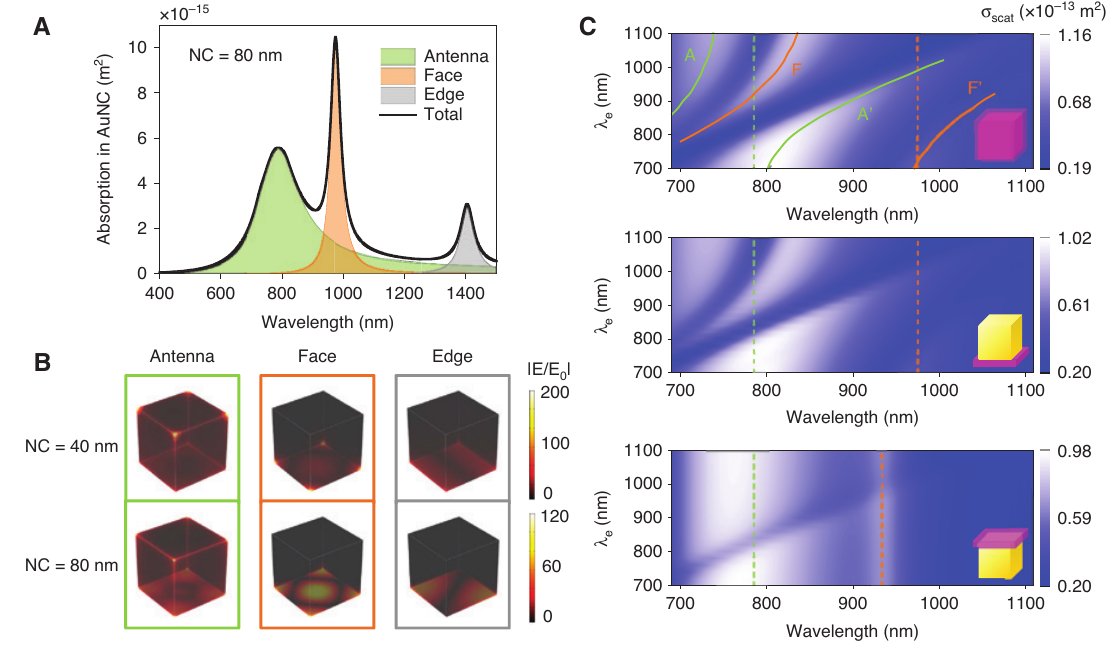
Figure 4: Multimode strong coupling in c -NCoM. (A) Eigenmode analysis by the QNM method for c -NCoM, with cube size of 80 nm and emitter thickness of 2 nm. Here, the higher-order modes at wavelength below 650 nm are omitted as we focus on the coupling between near-infrared emitters and antenna/face modes. (B) Mode profiles of the three eigenmodes identified from QNM simulations: antenna, face, and edge modes for c -NCoM with cube size of 40 nm (top row) and 80 nm (bottom row), respectively. (C) FDTD simulations demonstrating strong coupling for c -NCoM (cube size of 80 nm) with three different coating scenarios: (i) fully coated, (ii) partially coated only at the sbottom surface, and (iii) partially coated only at the top surface. The emitter wavelength λ is swept from 700 to 1100 nm to couple to multiple optical modes. The bare cavity resonances are e denoted for antenna mode (dashed green line) and face mode (dashed orange line). The corresponding split branches due to their coupling with emitters are denoted as A/A ′ for antenna mode (solid green curves) and F/F ′ for face mode (solid orange